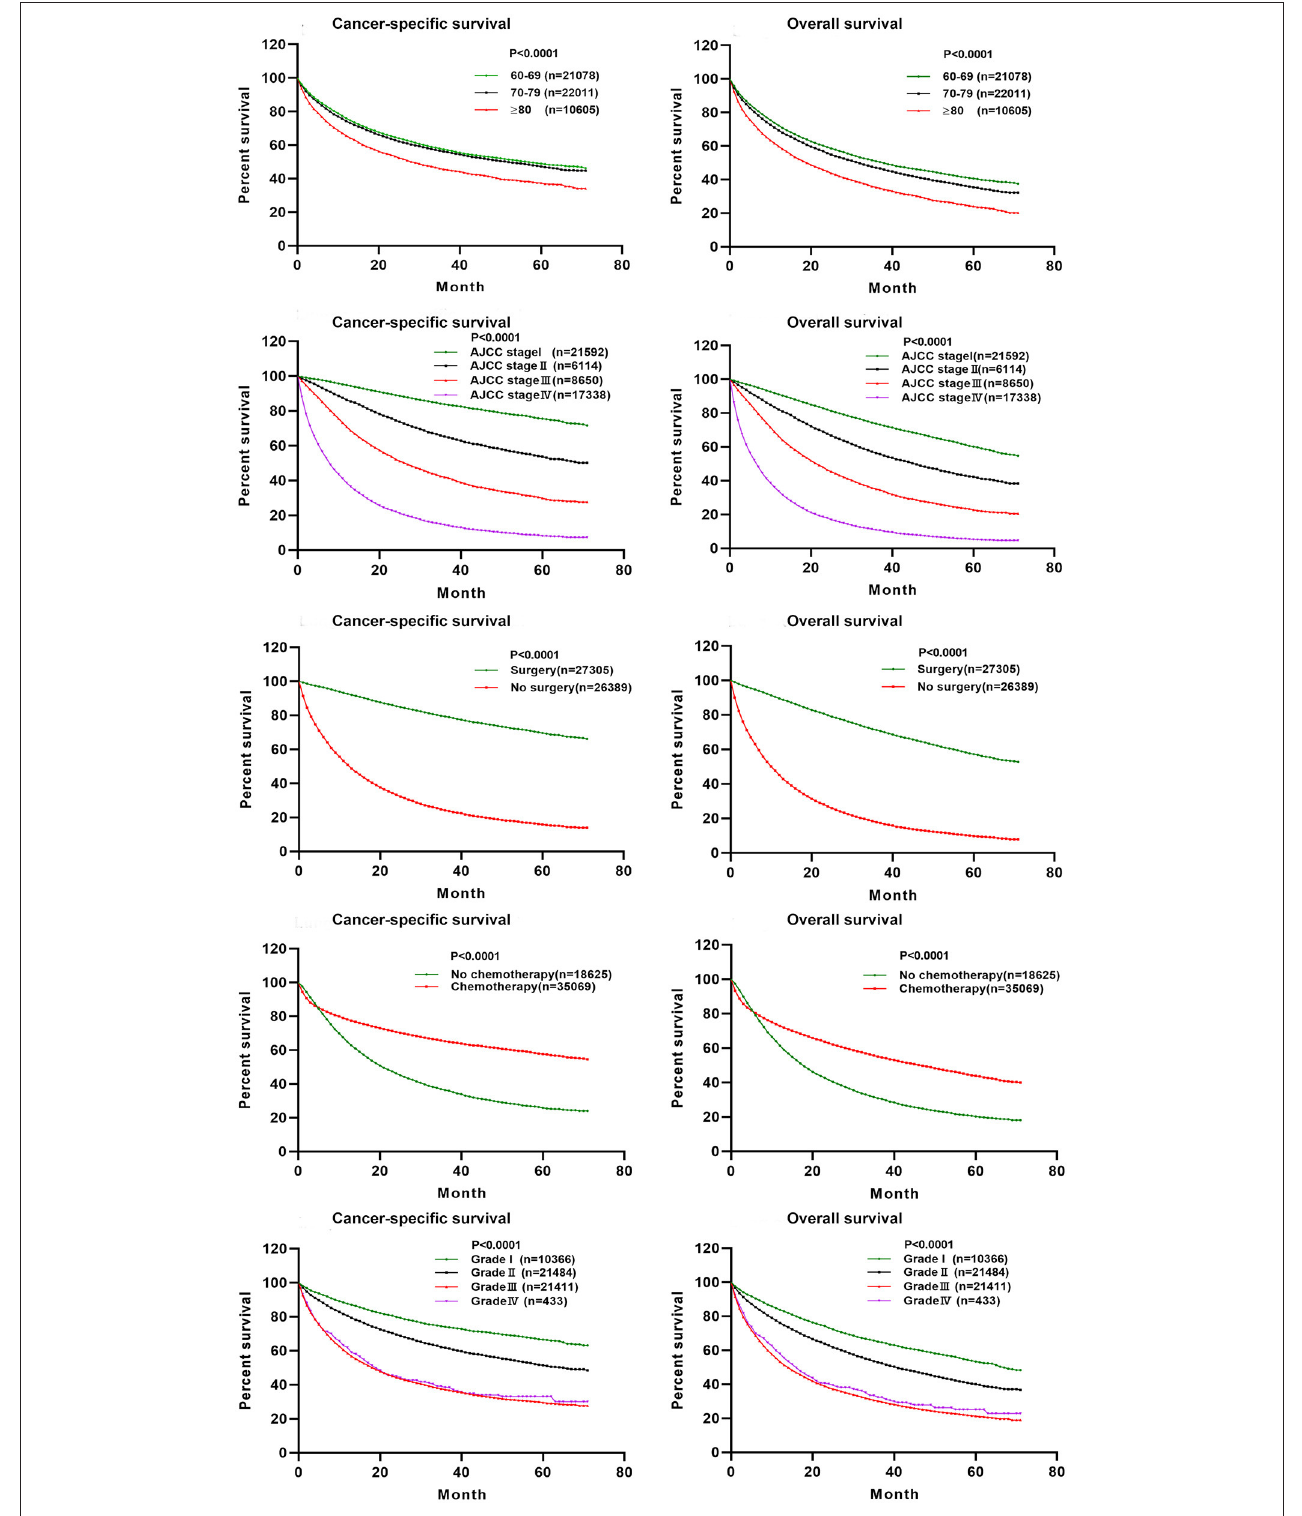
FIGURE 3 | The effect of AJCC staging, surgical treatment, chemotherapy treatment, histologic grade, and age at diagnosis on the cancer-specific survival and overall survival of elderly patients with lung adenocarcinoma. Kaplan–Meier curves for cancer-specific survival ( P < 0.001) and overall survival ( P < 0.001).